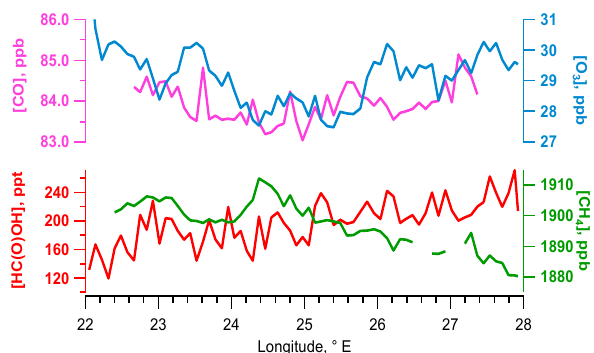
Figure 5. The concentration change in HC(O)OH, CH 4 , CO and O 3 along transect x in relation to longitude in ° E during flight B796b on 16 August 2013.